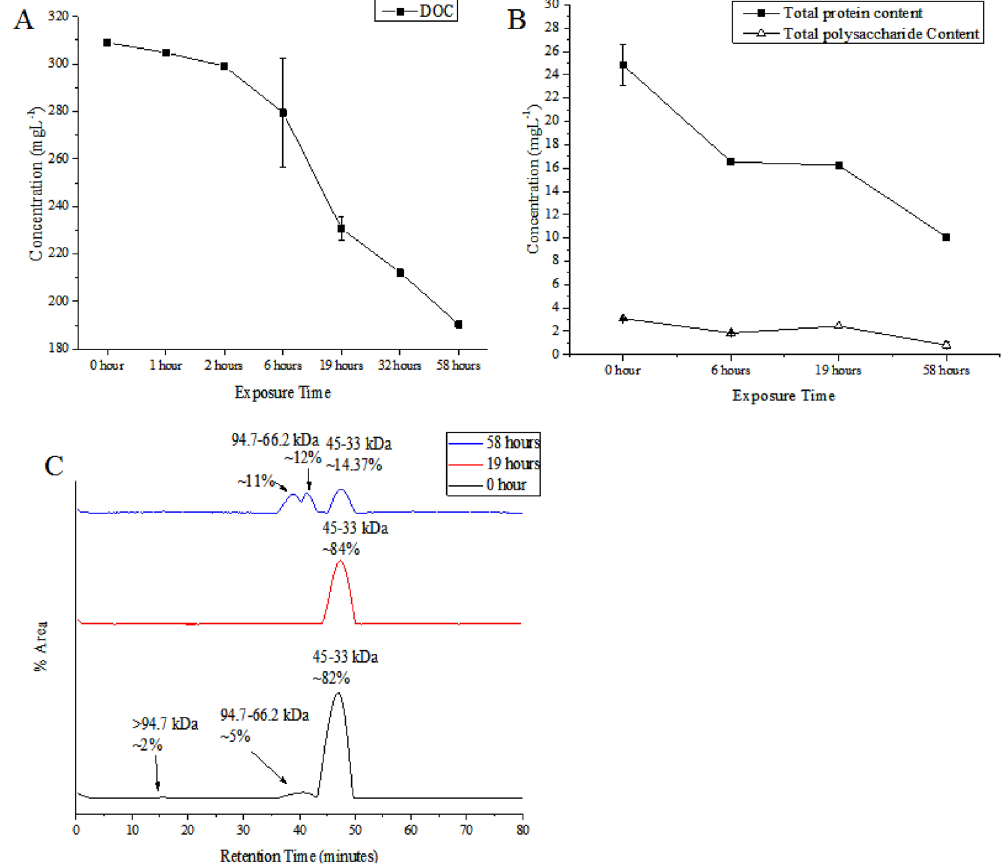
Figure 6. Influences of sunlight on photo-degradation of ( A ) DOC mgL − 1 content of EPS under light condition; ( B ) changes in total protein and total polysaccharide concentration during the exposure time and ( C ) Fingerprints of EPS protein molecular weight regions at 0 hour, 19 hours and 58 hours. Only daylight exposure hours (12 hours per day) were counted, to the exclusion of night